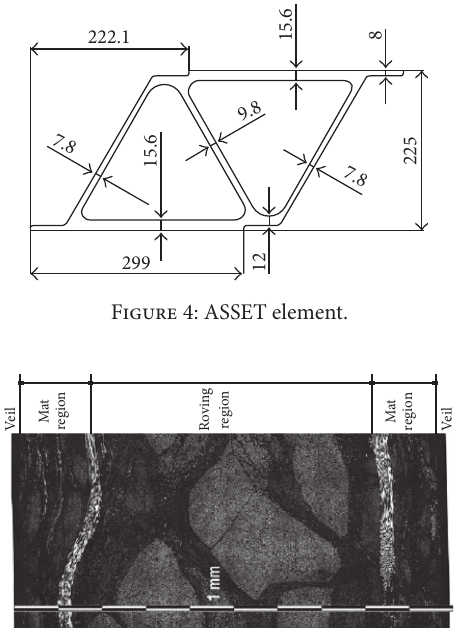
Figure 5: Cross-section of a 10mm GFRP profile [5].